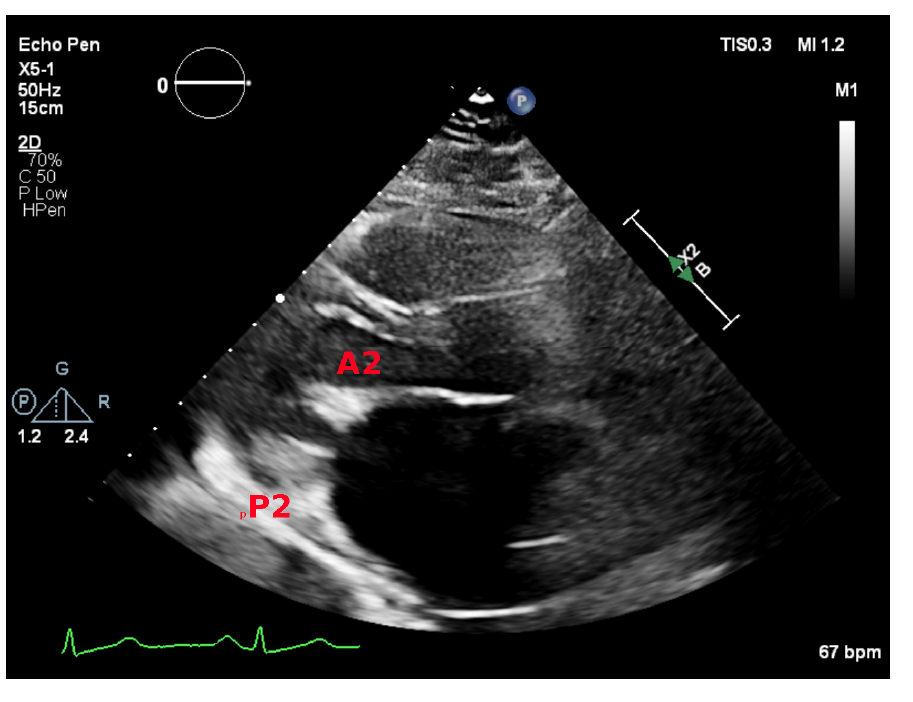
Figure 2. Parasternal long-axis view showing the A2 and P2 mitral